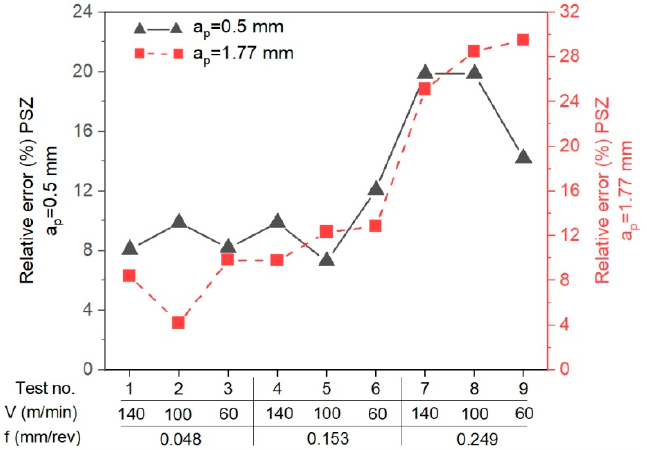
Figure 16. The relative error between the results from calculations and the results from measure- ments with the thermovision camera for each